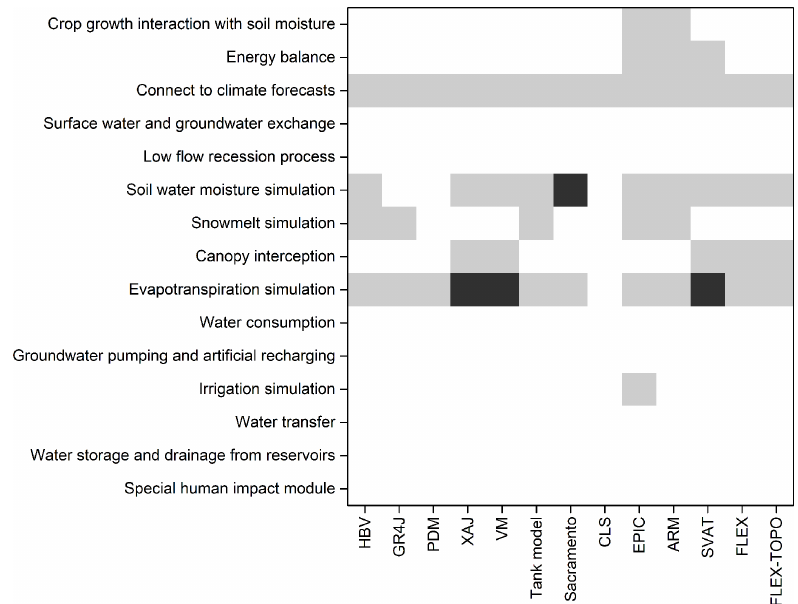
Figure 1. Evaluation of the adaptability of lumped hydrological models for drought forecasting. Where white color stands for grade 0 (no consideration of the function or module); gray color stands for grade 1 (simple simulation of the function or module); black color stands for grade 2 (powerful simulation of the function or